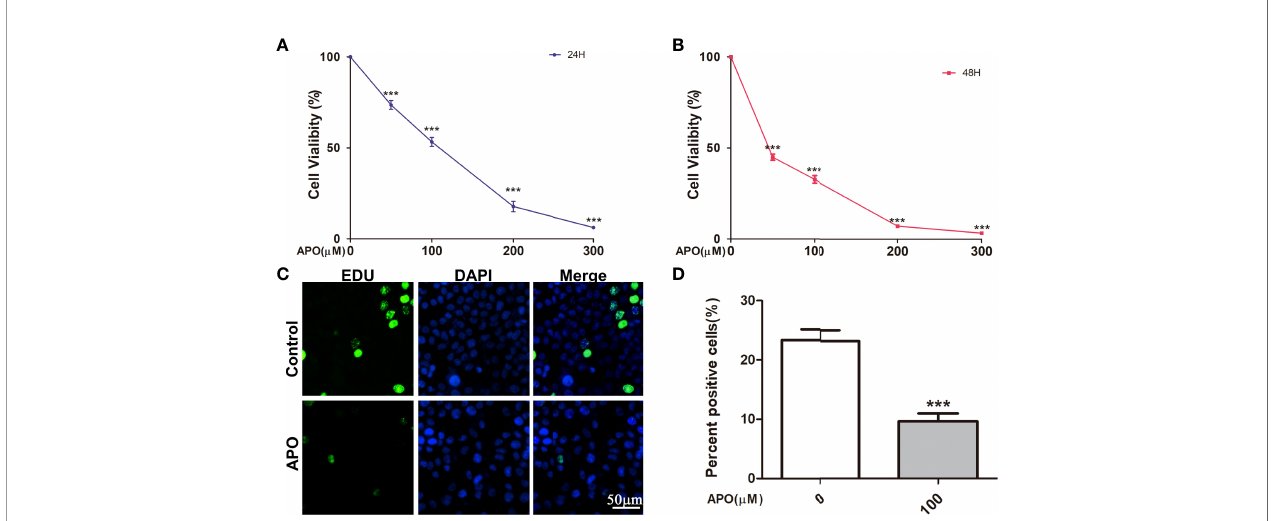
FIGURE 5 | APO inhibits OSCC cell proliferation in vitro. Cell Counting Kit (CCK8) assay shows the suppressive effect of APO after 24-h (A) and 48-h (B) treatment by CCK8 assay and 5 ′ -ethynl-2 ′ -deoxyuridine (EdU) assay (C) . Means ± SEM; *** P < 0.001; two-way ANOVA analysis. (D) Quanti fi cation of EdU assay. Means ± SEM; *** P < 0.001; Student ’ s t-test analysis; APO, apoptozole.